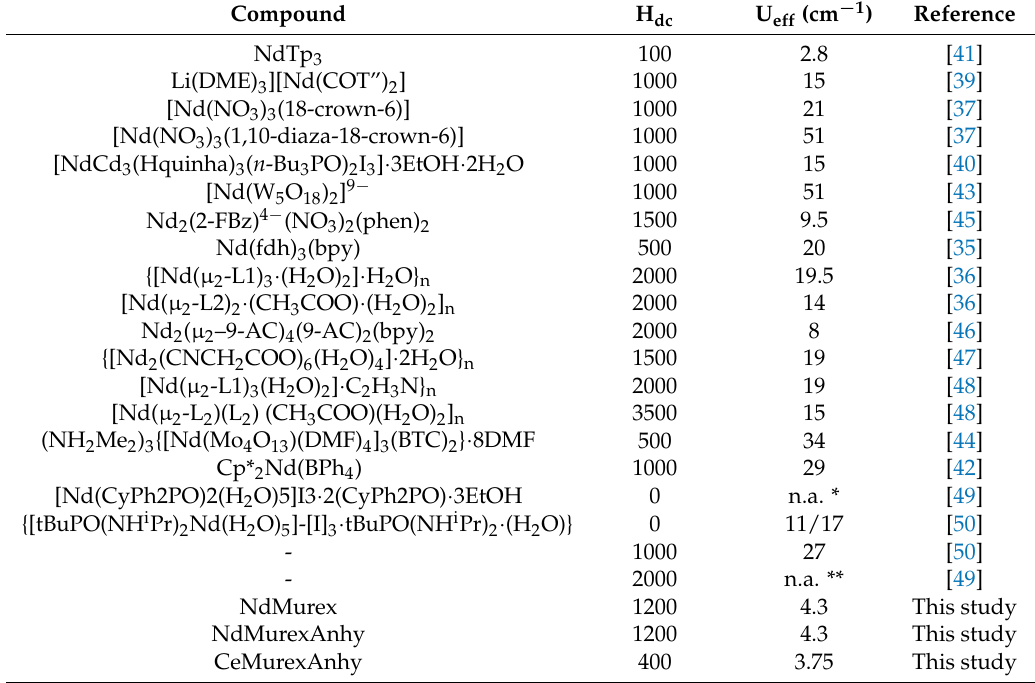
Table 1. Table of Nd III -based Single-Molecule Magnets with U eff values and references